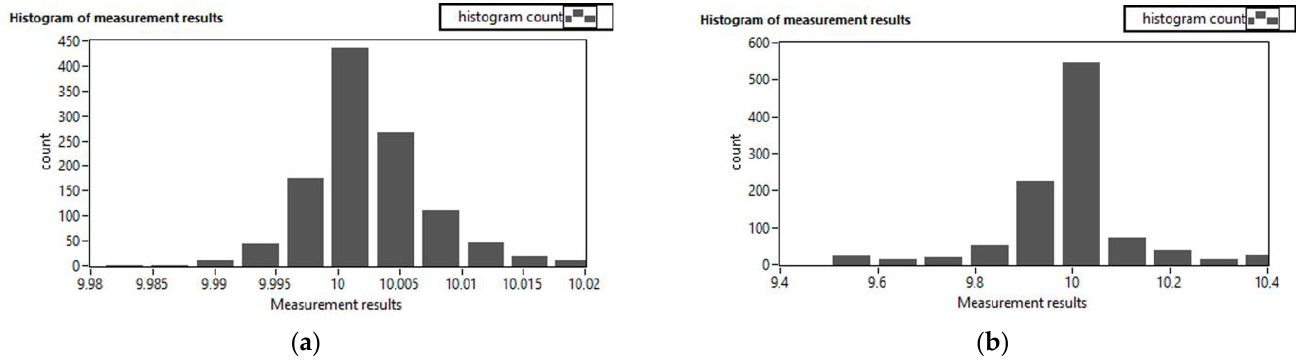
interference level.